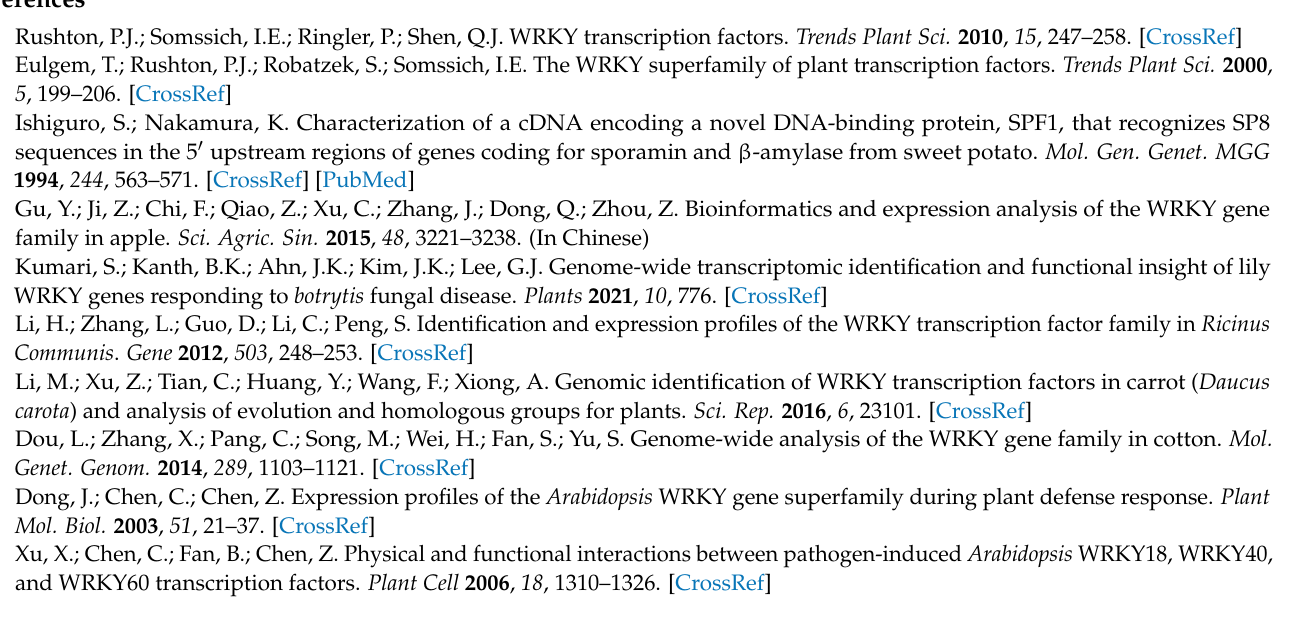
Table S2: Gene list of segmental and tandem duplication. Table S3: Sample of tissues and stage/treatment used for RNA-Seq. Table S4: The expression data of MaWRKYs in banana fruit development and ripening stages. Table S5: The expression data (log2 Ratio Cold/Control) of the MaWRKYs after cold treatment. Table S6: The expression data (log2 Ratio Osmotic/Control) of the MaWRKYs after osmotic treatment. Table S7: The expression data (log2Ratio Salt/Control) of the MaWRKYs after salt treatment. Table S8: The expression data (log2 Ratio 2 DPI/0 DPI) of the MaWRKYs after inoculated Foc TR4. Table S9: PCR primers for expression analyses of MaWRKYs . Table S10: The characteristics of linked proteins with MaWRKY21 . Table S11: Comparison with the number of genes in previous articles. The red font is the different gene in the two